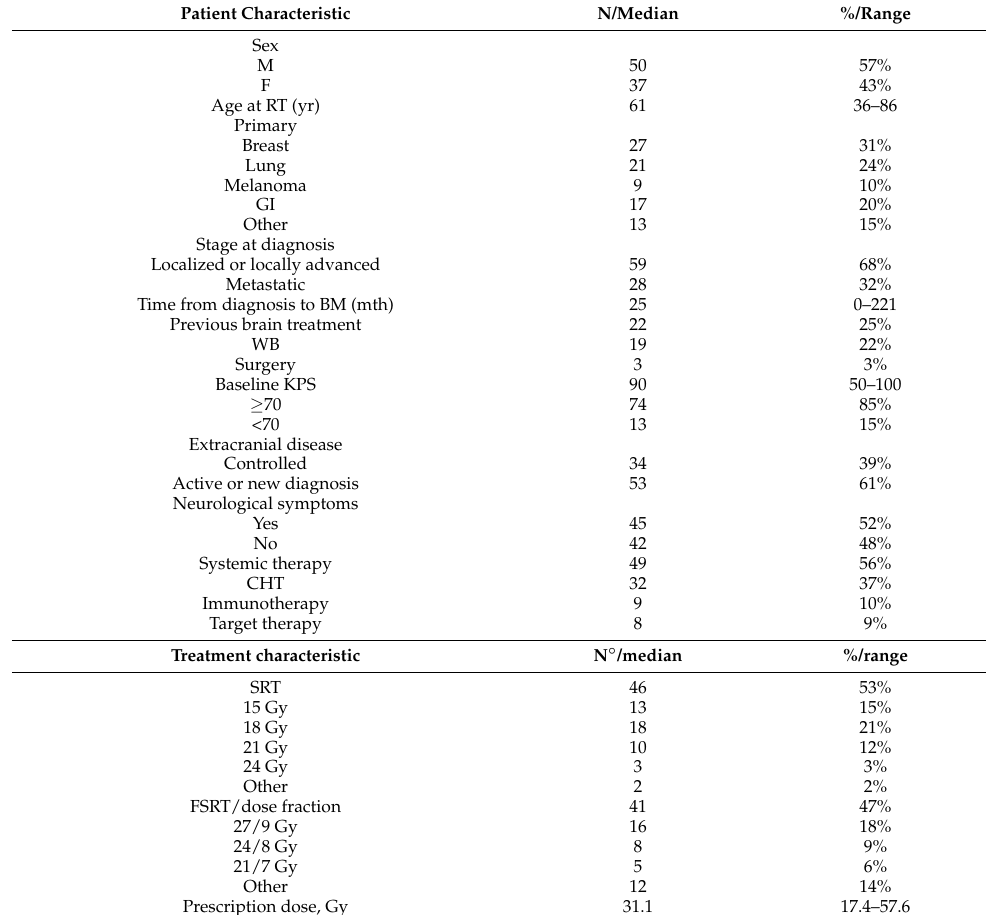
Table 1. Clinical and treatment characteristic of the 87 analyzed